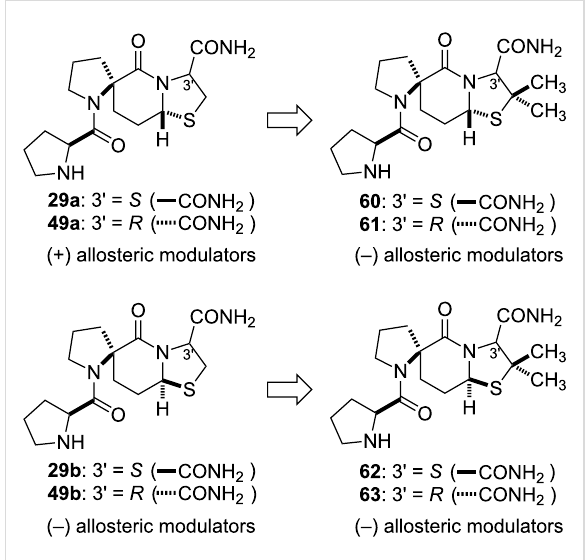
showed significant negative modulatory activity, as demon- strated by their ability to negatively affect the binding of the dopamine receptor agonist NPA to the D 2 receptor and to shift the EC 50 value for [ 3 H]NPA binding to dopamine D 2 receptors by 2.7- and 2.8-fold, respectively, compared to the control [58]. Thus, both compounds decreased the affinity of the agonist NPA to the D 2 dopamine receptor. The results supported the proposition that the introduction of dimethyl groups into the structure of the positive modulators resulted in molecules that resembled the conformational characteristics of the unsubsti- tuted negative allosteric